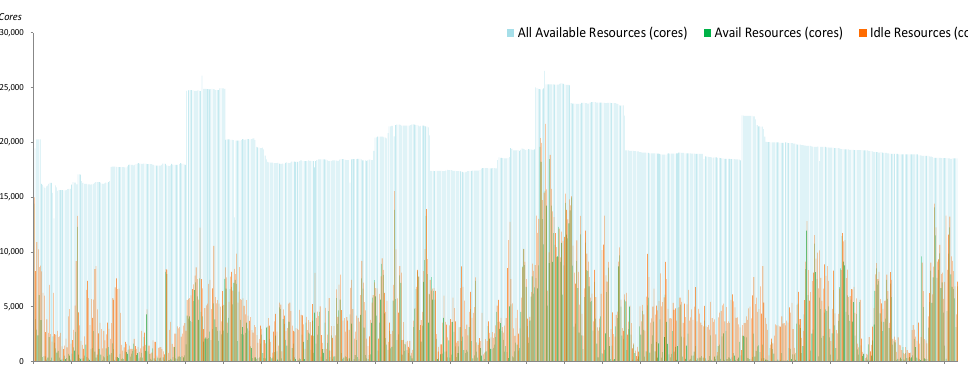
Figure 3. Statistics of the large-scale jobs counts.